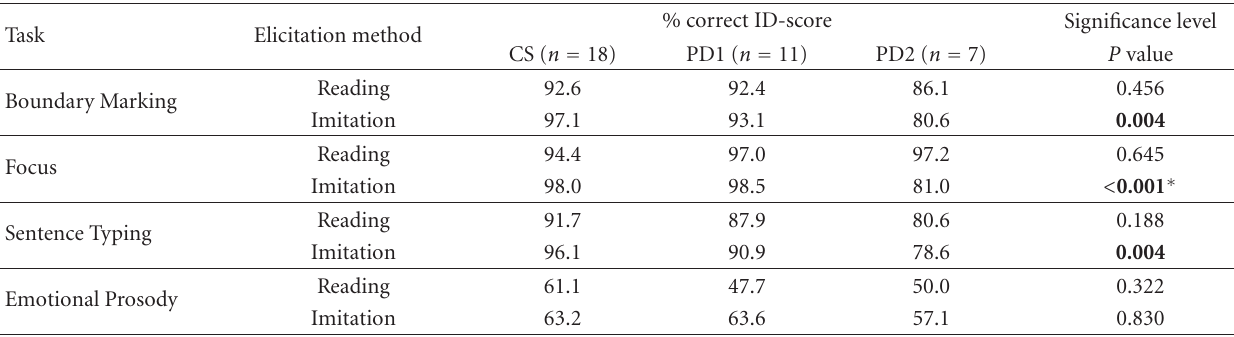
Table 5: Results for 3 speaker groups: % correct identification scores and P -values resulting from χ 2 test (statistically significant P -values in bold print).